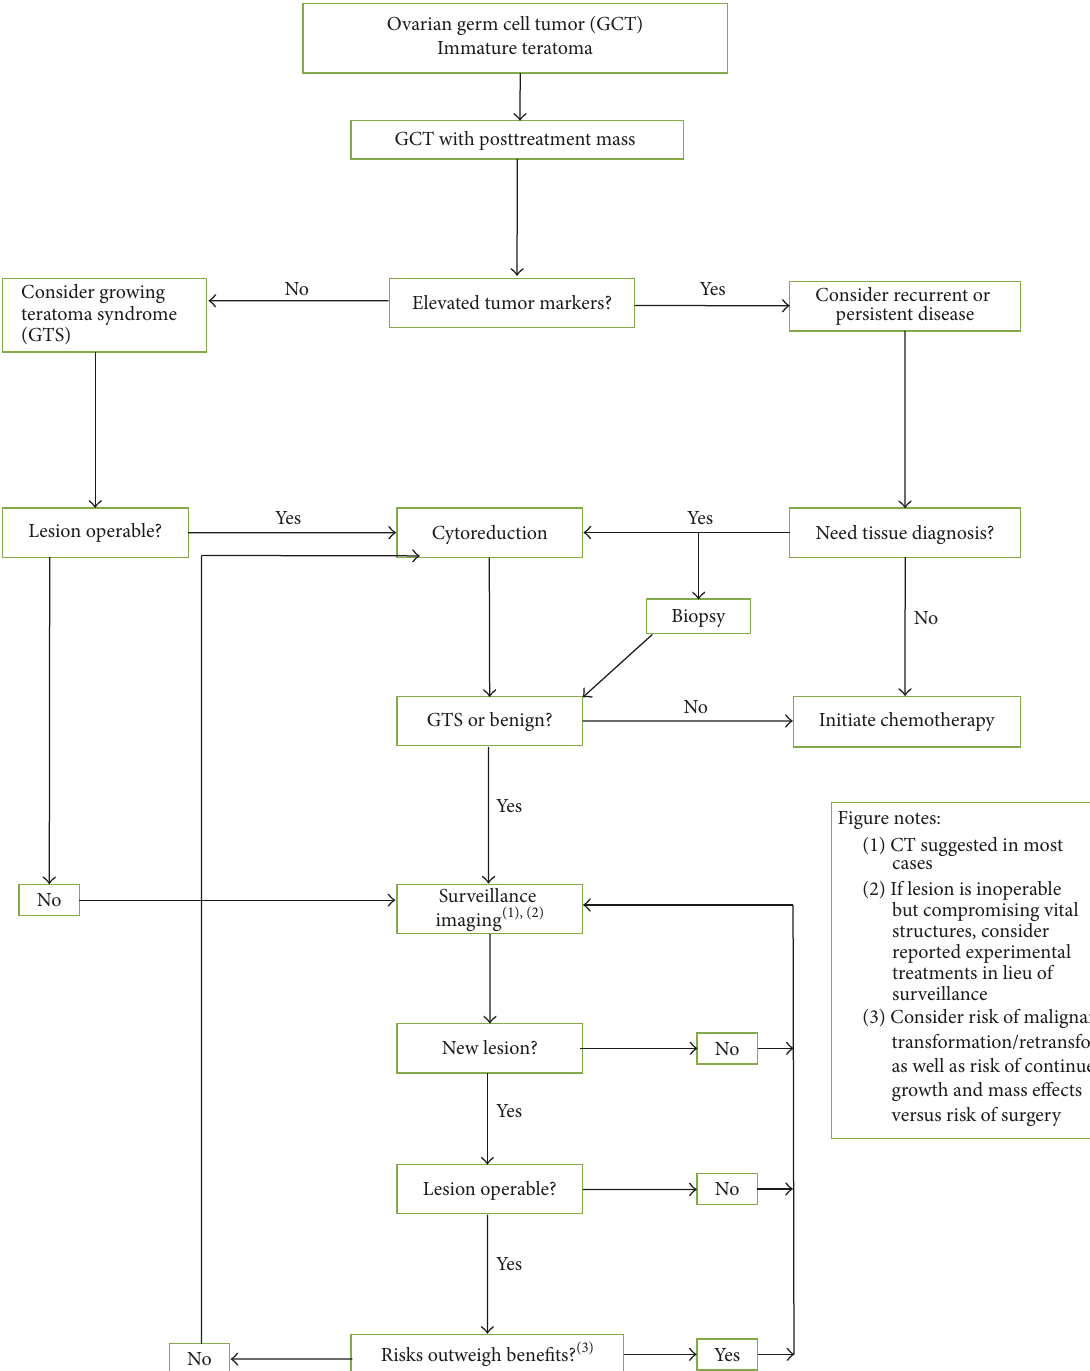
Figure 5: Algorithm suggested for management of pediatric female patients with ovarian germ cell tumors following initial resection of immature teratoma and completion of therapy. GCT, germ cell tumor; GTS, growing teratoma syndrome. Modified from Byrd et al. with